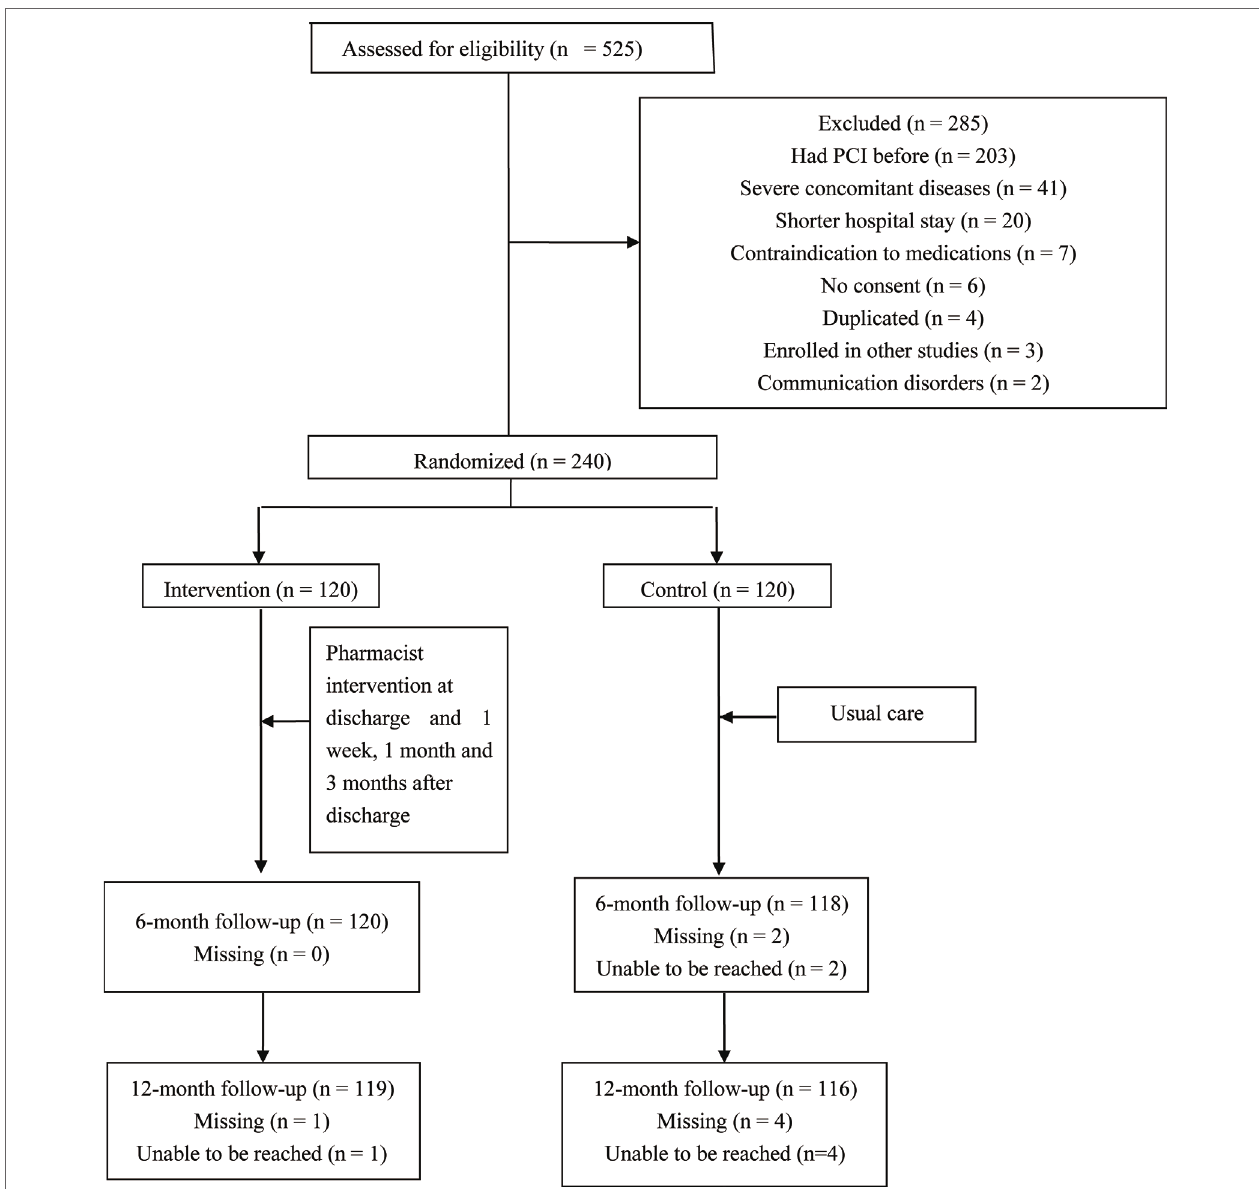
FIGURE 1 | Trial protocol overview. PCI indicates percutaneous coronary